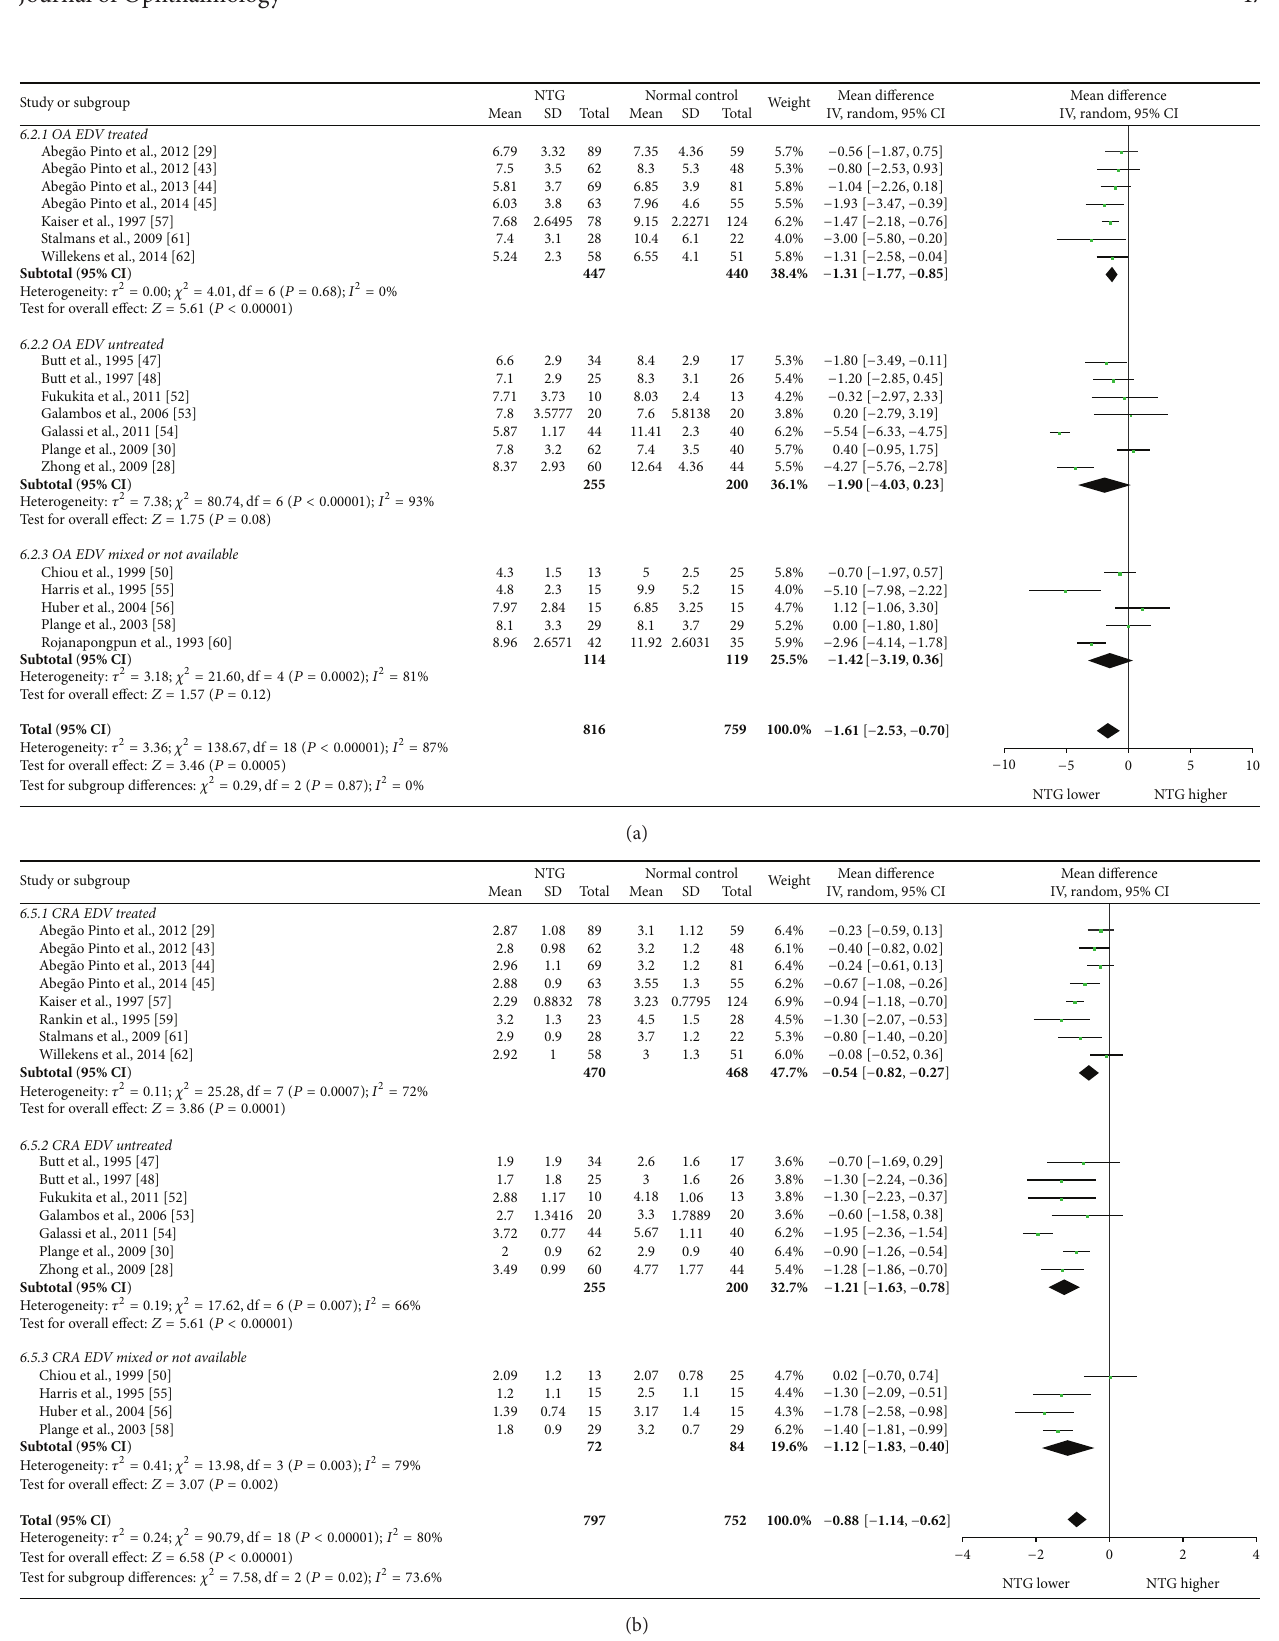
Figure 6: Forest plot of EDV in OA and